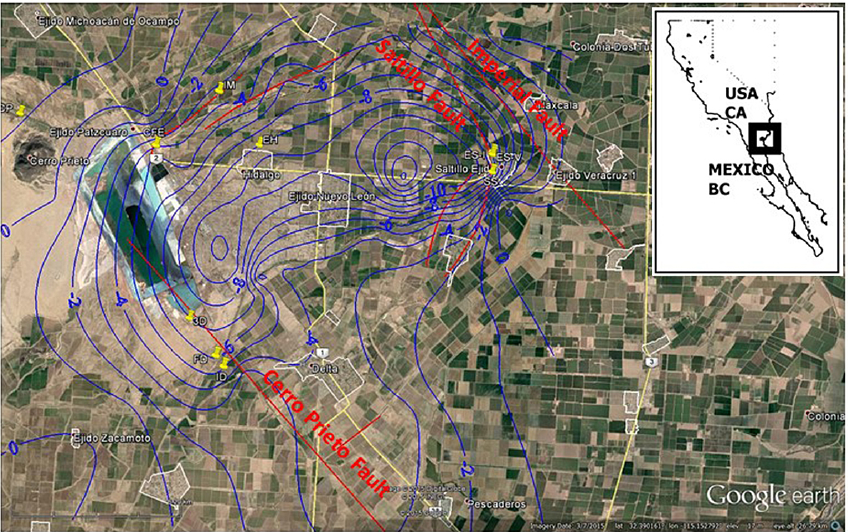
Figure 1. Instruments (yellow pins) and the subsidence rate blue isolines (cmyr − 1 ) for 1997–2006 (modified from Glowacka et al., 2011). Red lines indicate tectonic faults. The inset shows the geographical location of the study